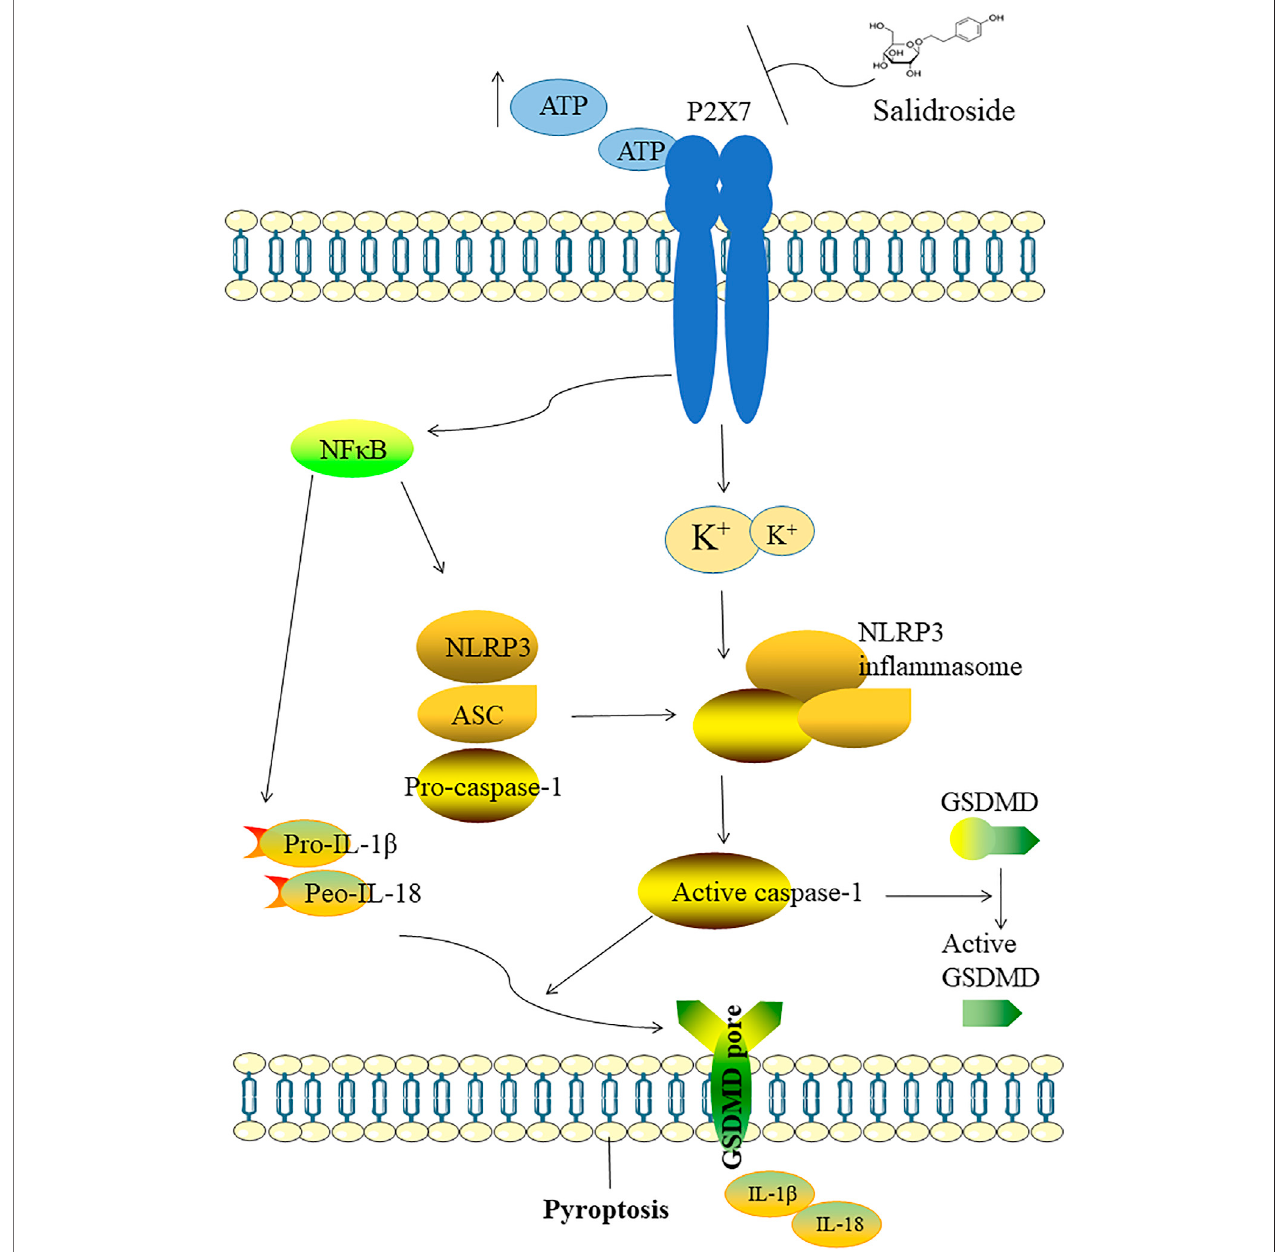
FIGURE10| Illustration ofthemechanismwhichSalimprovesdepression throughsuppressingNLRP3-mediatedpyroptosis.ThepossiblemechanismofSalisas follows: Sal suppresses NLRP3-mediated pyroptosis through inhibiting P2X7/NF- κ B/NLRP3 signaling pathway.